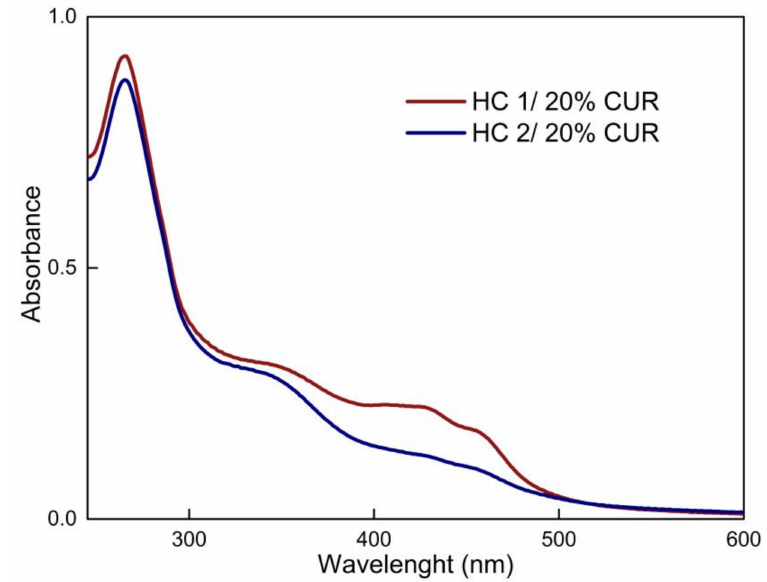
Figure 9. UV-Vis spectra of the CUR loaded